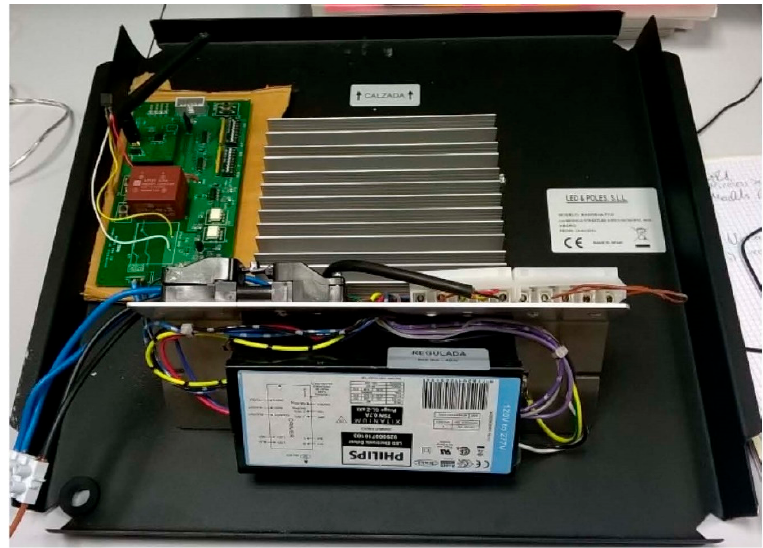
Figure 17. System used in the lab to control a 46 W LED lamp.